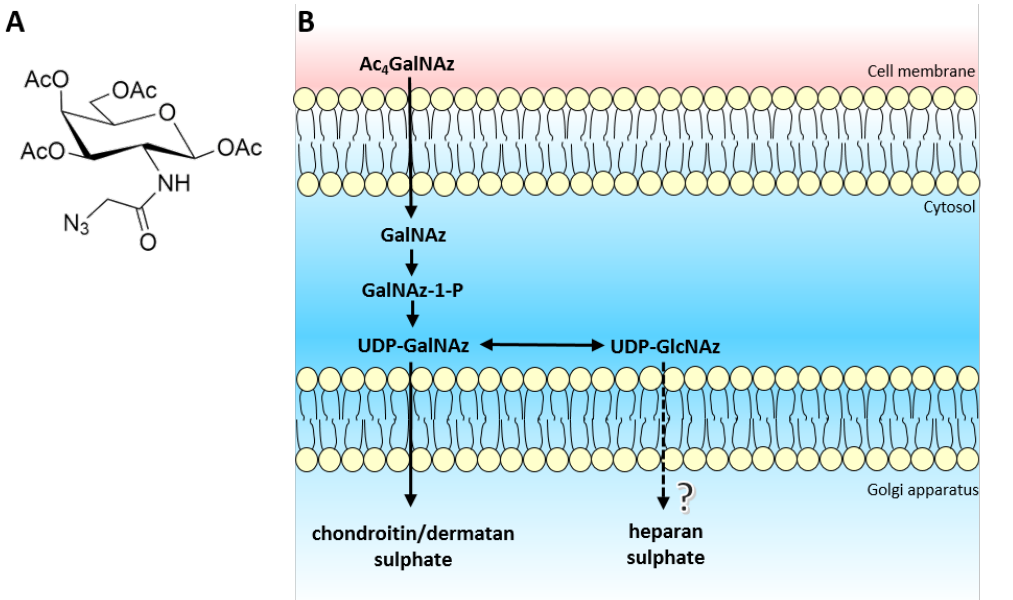
Figure 1. ( A ) Structure of tetra-acetylated N -azidoacetylgalactosamine. ( B ) Schematic of biological azido sugar precursor production for GAG synthesis. Ac 4 GalNAz travels across the cell membrane and enters the cytoplasm. Endogenous deacetylases remove the acetyl protective groups leaving GalNAz, ready to enter the GalNAc salvage pathway. After a cascade of enzymes, both UDP-GalNAz and UDP-GlcNAz are produced, which target CS/DS and potentially HS biosynthesis